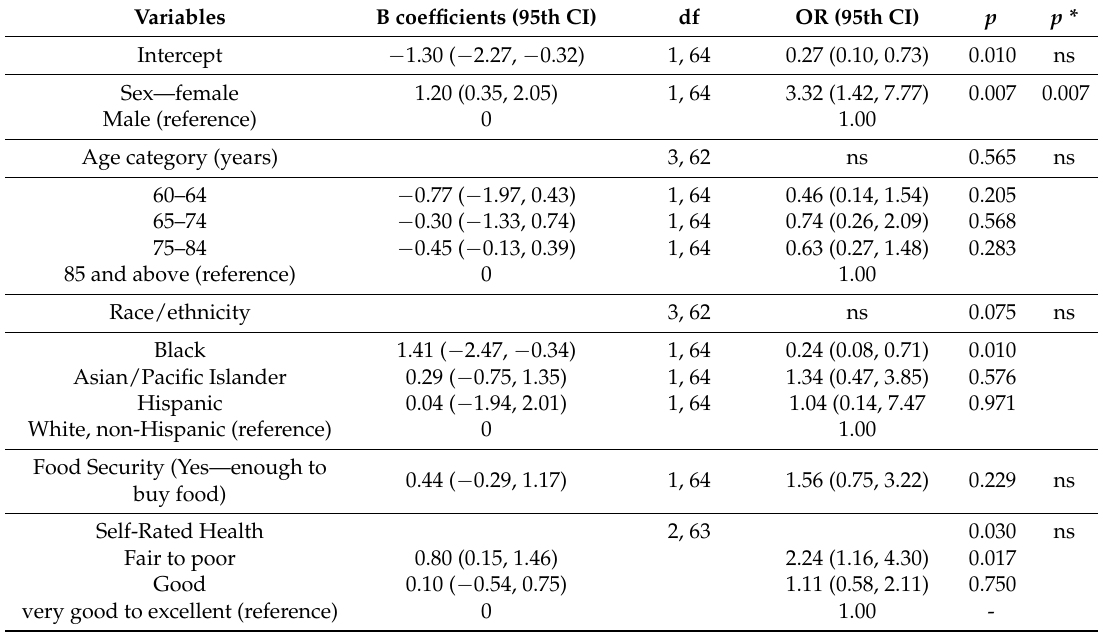
Table 4. Logistic regression model for participant characteristics and odds of osteoporosis.